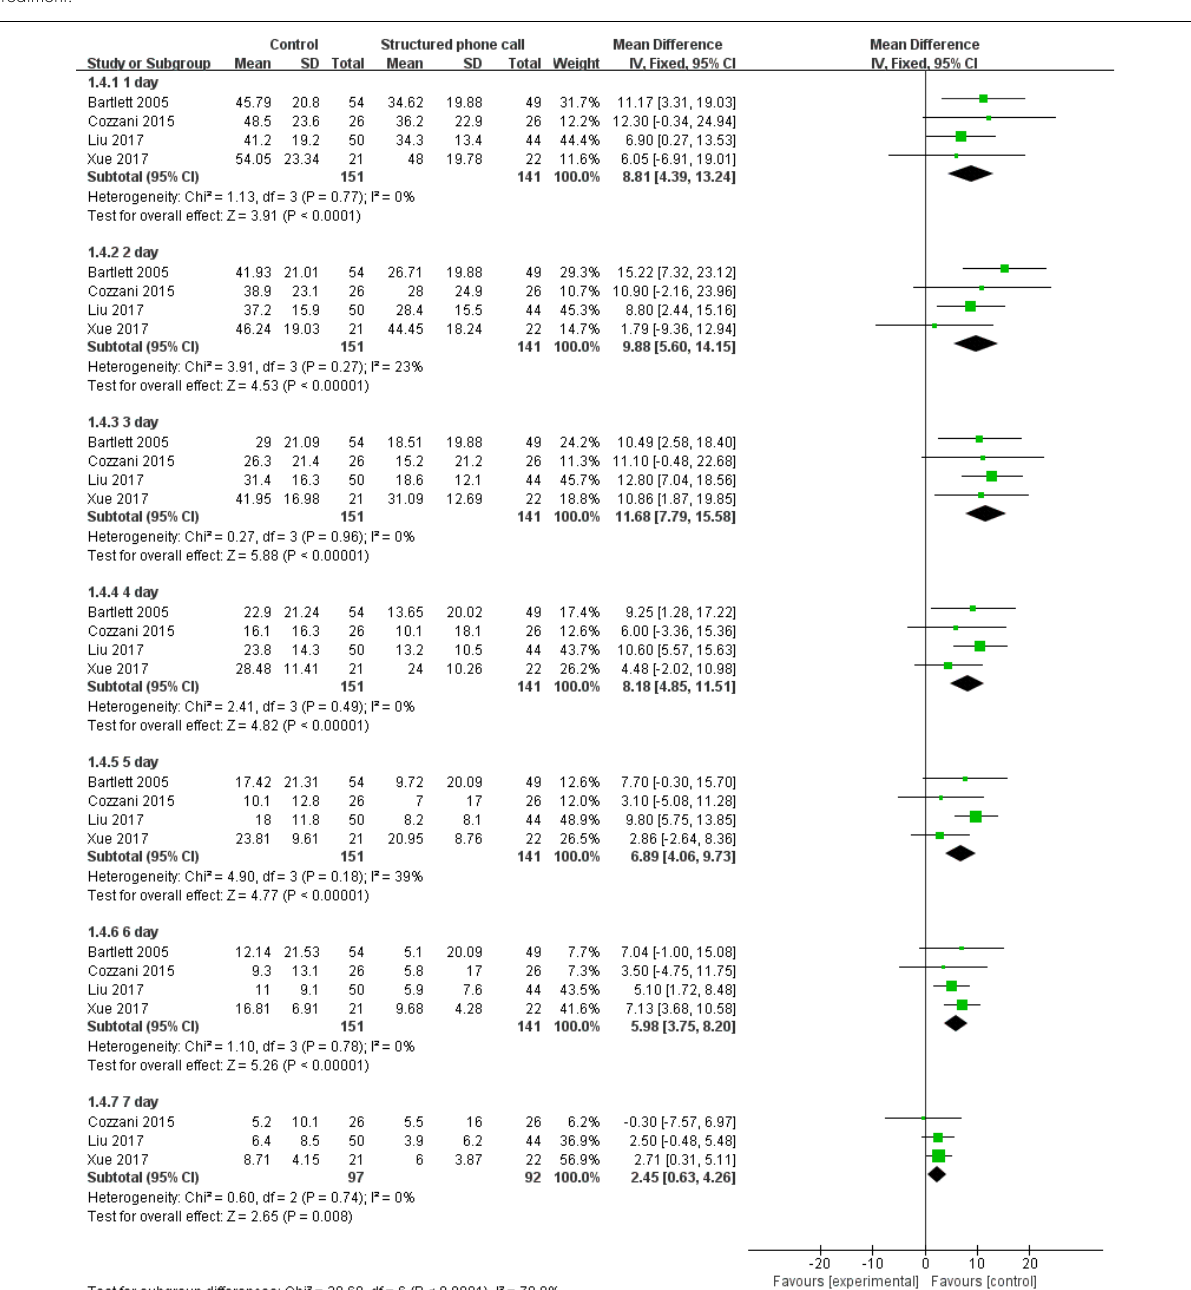
Supplementary Figure 4. Structured phone call follow-up and control for meta-analysis results, reported in mean difference (95% confidence interval), show evidence favouring structured phone call follow-up for pain reduction effectiveness daily within a week after activation of fixed orthodontic